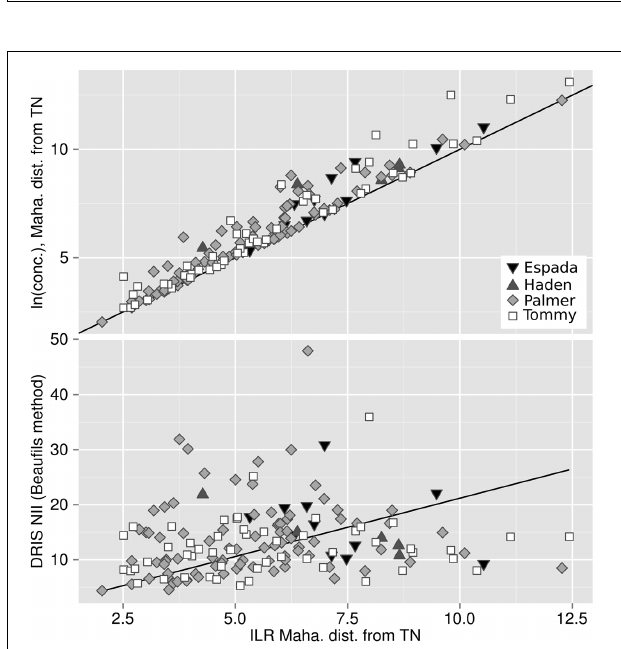
FIGURE 6 | Bias measured by discrepancy between the Mahalanobis distance from the TN population across the isometric log ratios (x-axis) and (top) the Mahalanobis distance from the TN population across the natural log of concentrations and (bottom) the DRIS nutrient imbalance